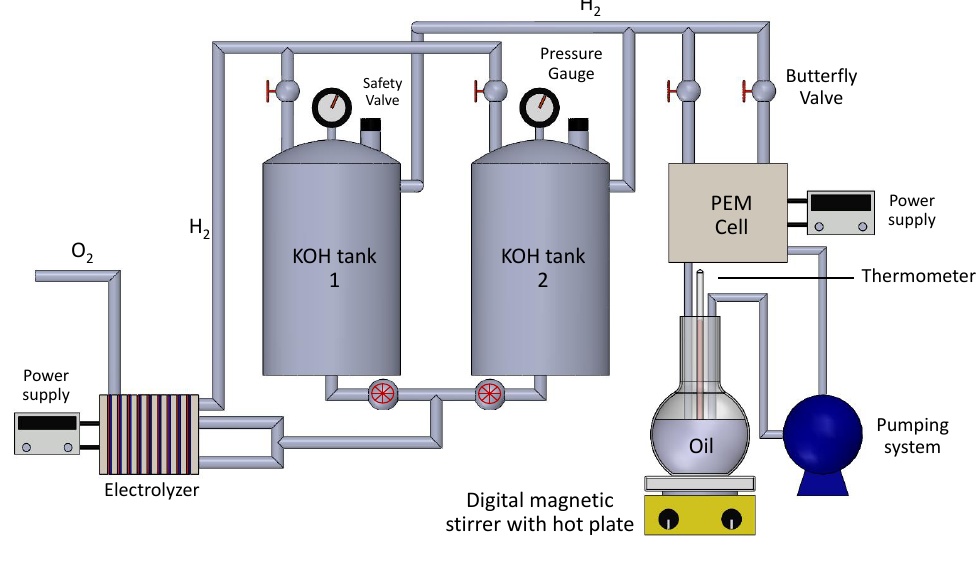
Figure 2. Hydrogen generation system and hydrogenation